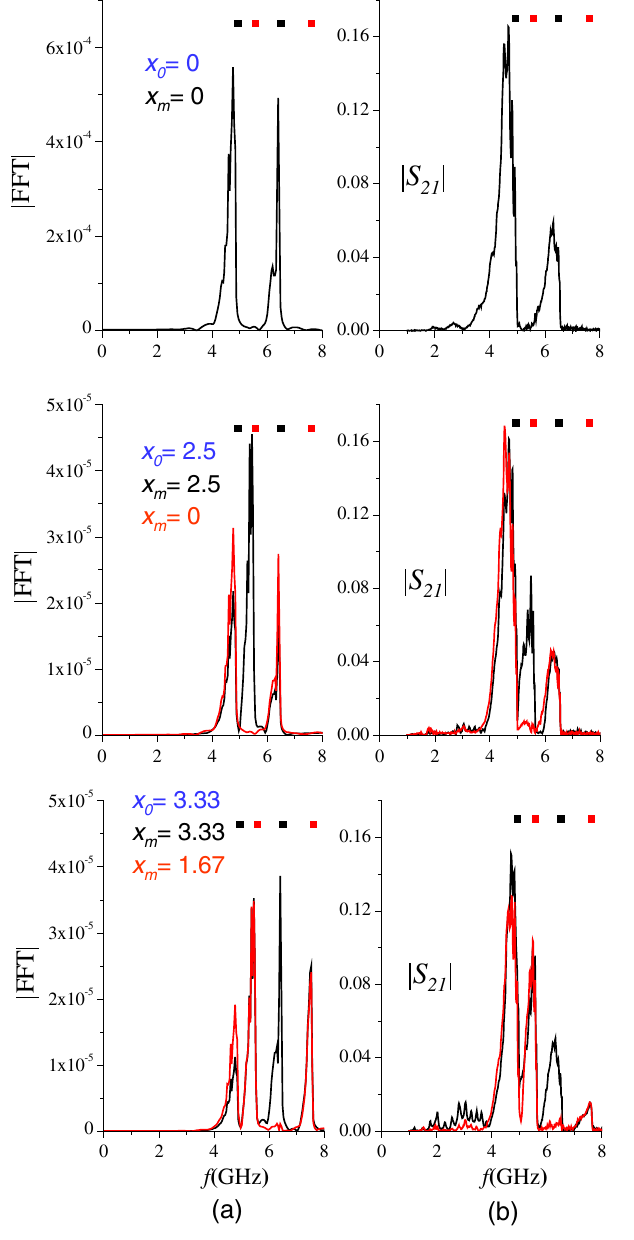
FIG. 5. (a) The moduli of the FFTs of pings emitted at trans- . (b) The moduli of the verse position x 0 , and observed at x m measured transmission coefficient S 21 for the same emission and measurement points. The theoretical band heads for symmetric (black) and antisymmetric modes (red) are indicated by small squares. See also Table I.